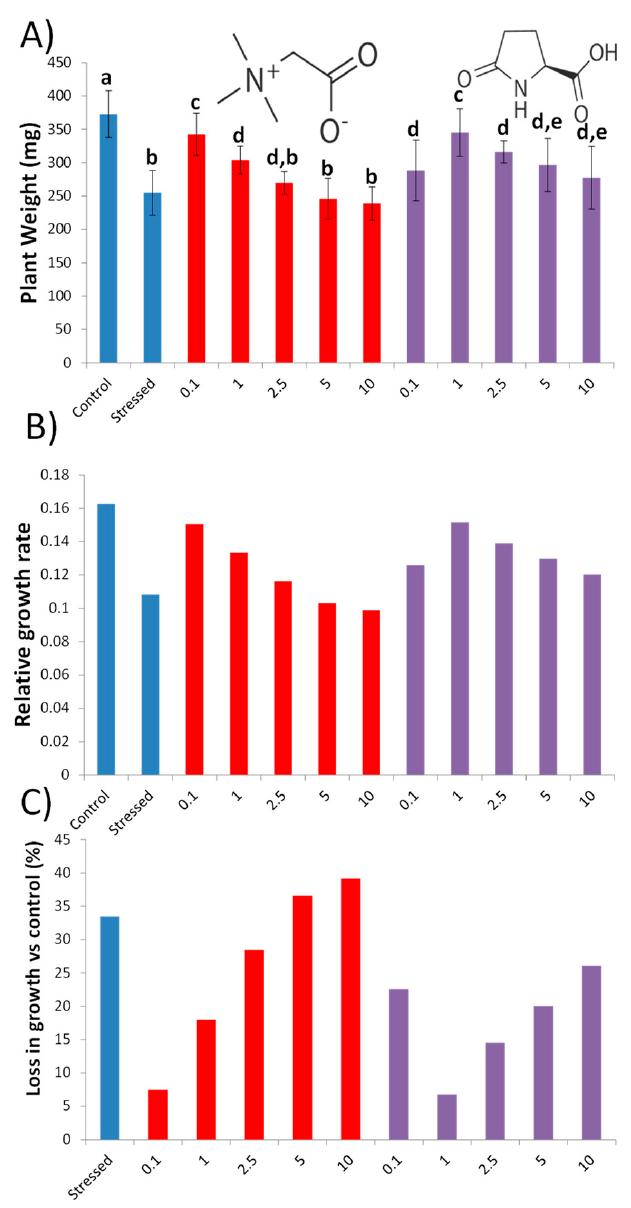
Figure 1. Hydroponic dosage evaluation using PEG 20% as a stressor. Red and violet correspond to GB and PG treatments, respectively. ( A ) Plant weight in mg. ( B ) Relative growth rate. ( C ) Percentage growth loss against control. Bars labelled with the same letter showed no significant differences at p < 0.05.